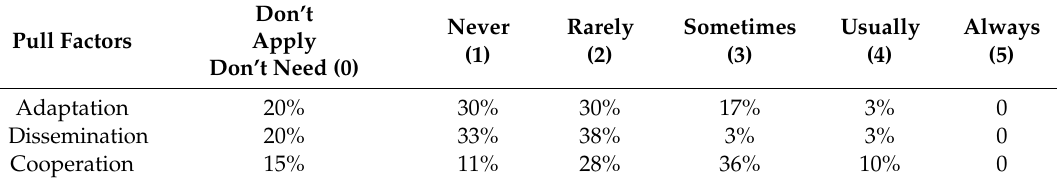
Table 2. Frequency distribution of push